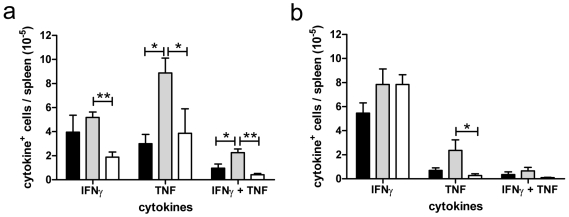
AC treatment affects T cell cytokine production.PbA infected (grey bars) and PbA-infected oAC-treated (black bars) mice were killed on day 6 and cytokine measured after PMA stimulation. The absolute number of splenic IFNγ+, TNF+ and IFNγ+TNF+ CD4+ (a) and CD8+ (b) are shown. Uninfected mice (open bars) are shown as baseline. Data represent mean ± SE (n = 10 individual mice from 2 independent experiments). *, p<0.05; **, p<0.01; ***, p<0.001.